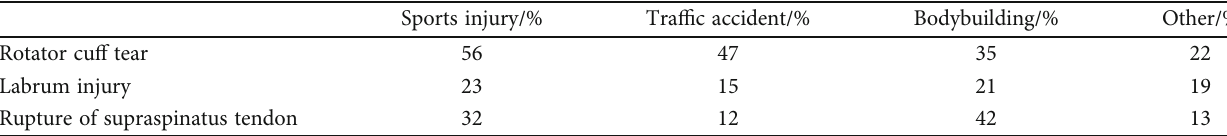
Table 7: Comparison of the causes of shoulder joint injury.